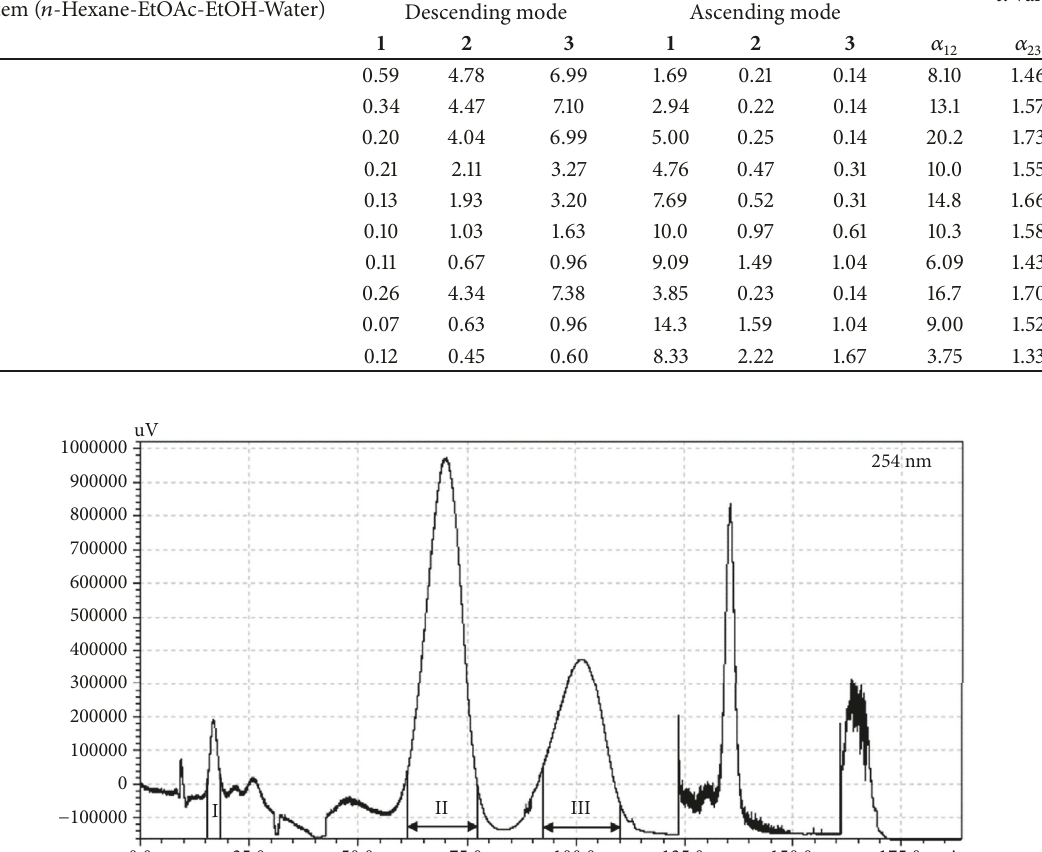
Table 1: The partition coefficient (K) and separation factor ( 𝛼 ) of compounds 1 – 3 in different solvent systems. Solvent system ( 𝑛 -Hexane-EtOAc-EtOH-Water)